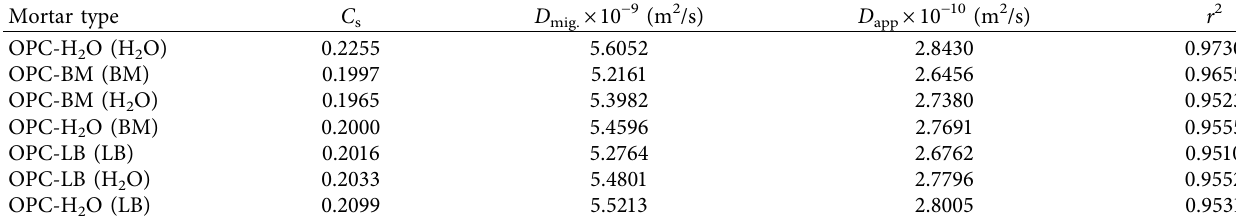
Table 4: C 2 –values for different microbial mortars in NaCl. S , D mig , D app , and r